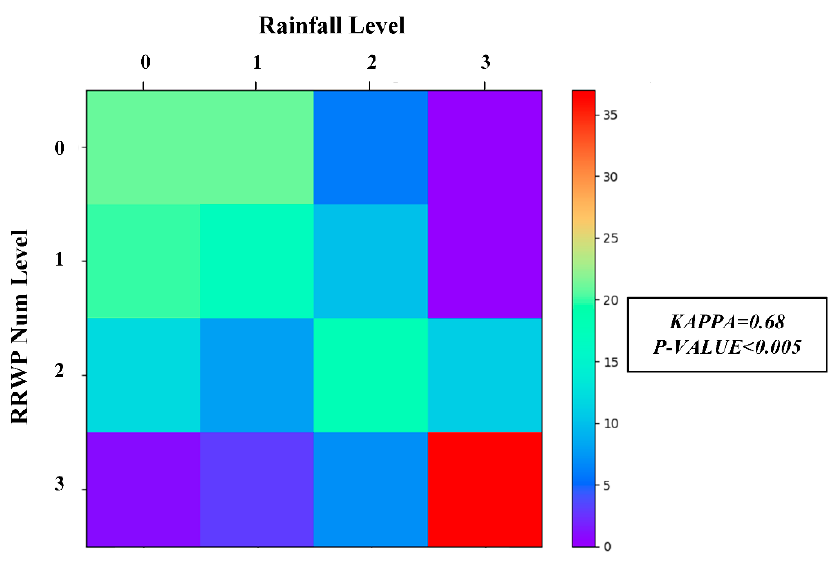
Figure 7. Consistency between rainfall and RRWP levels.